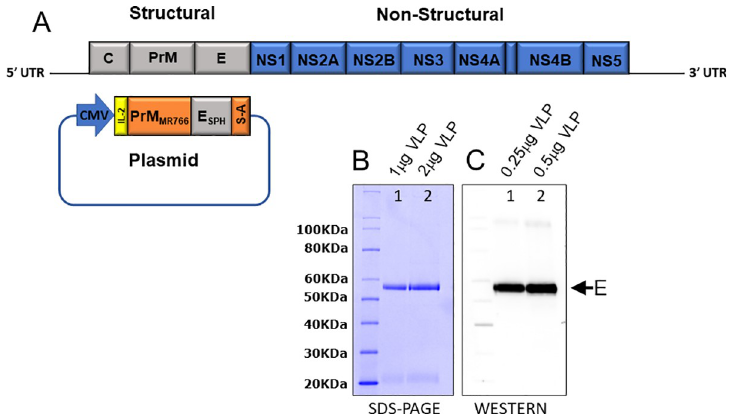
Fig 1. Design, production, purification, and characterization of ZIKV VLP vaccine candidate. (1A) Schematic of ZIKV genome and plasmid DNA encoding ZIKV structural genes: 1) prM derived from the MR766 African strain (orange) with native signal sequence replaced with the human IL2 sequence (yellow) (MYRMQLLSCIALSLALVTNS); 2) E ectodomain derived from the SPH2015 Brazilian strain (grey), and 3) E stem-anchor (S-A) from MR766 (orange).